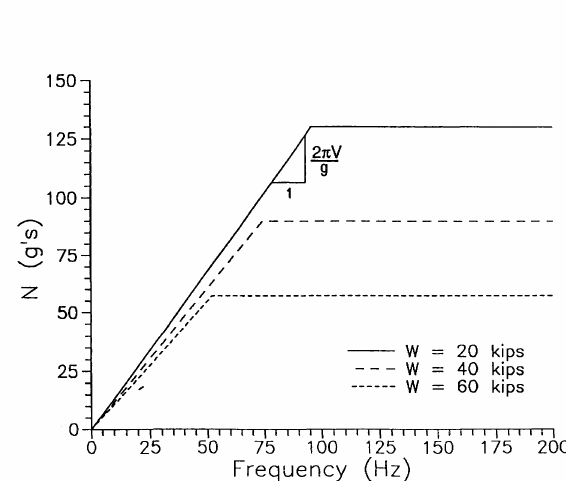
FIGURE 2 Typical shock design curves for different modal weights as a function of the fixed base frequen